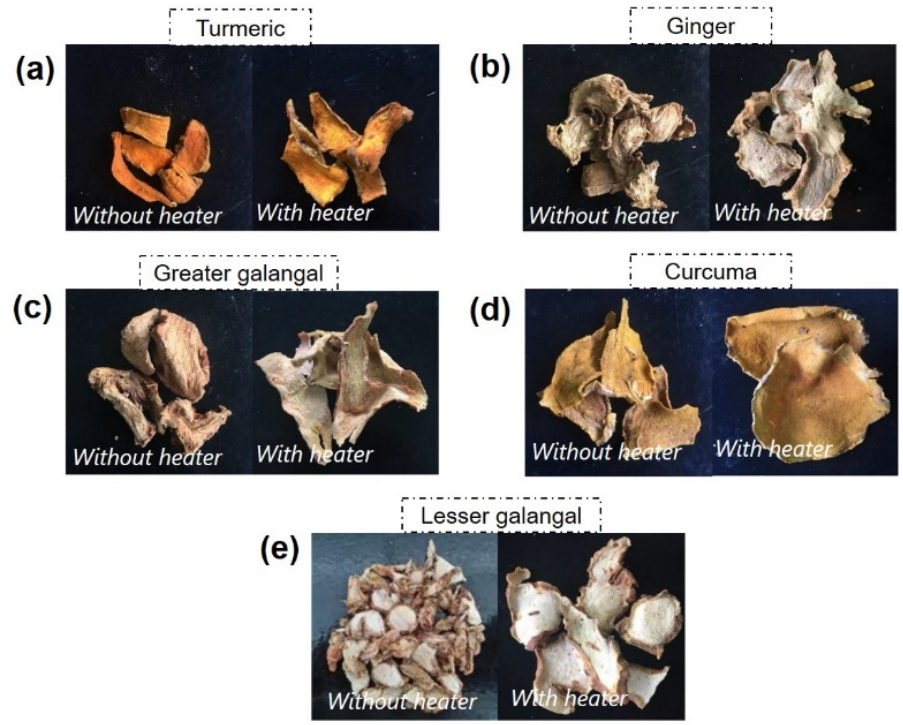
Figure 8. Dried medicinal plant samples produced in the Polydryer with and without heater oper- ation: ( a ) turmeric, ( b ) ginger, ( c ) greater galangal, ( d ) Curcuma, ( e ) lesser galangal.